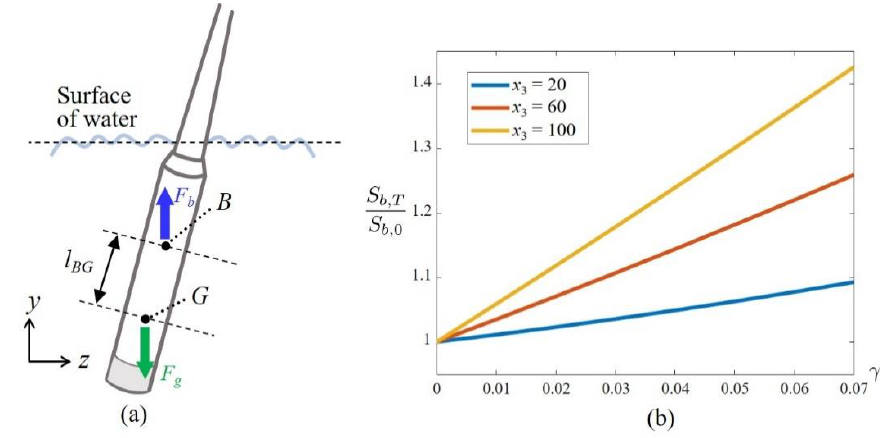
Figure 3. Restoring effect due to buoyancy force. ( a ) Buoyancy force and gravitational force acting on FOWT platform. ( b ) Changes in stability due to tuned mass damper.